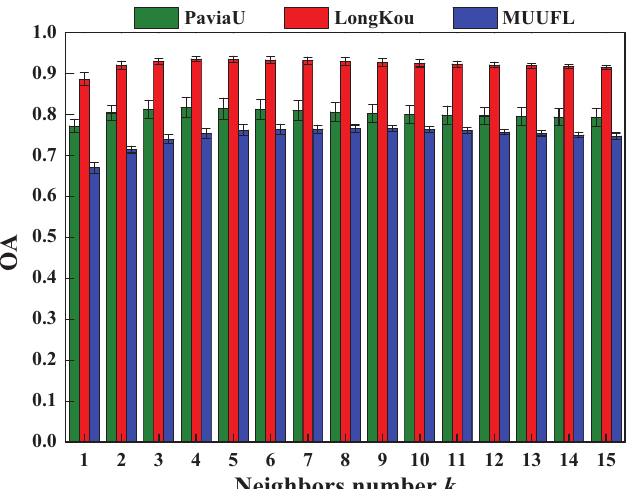
Figure 5. Classification results with different neighbors number of k on three hyperspectral image (HSI) data sets.